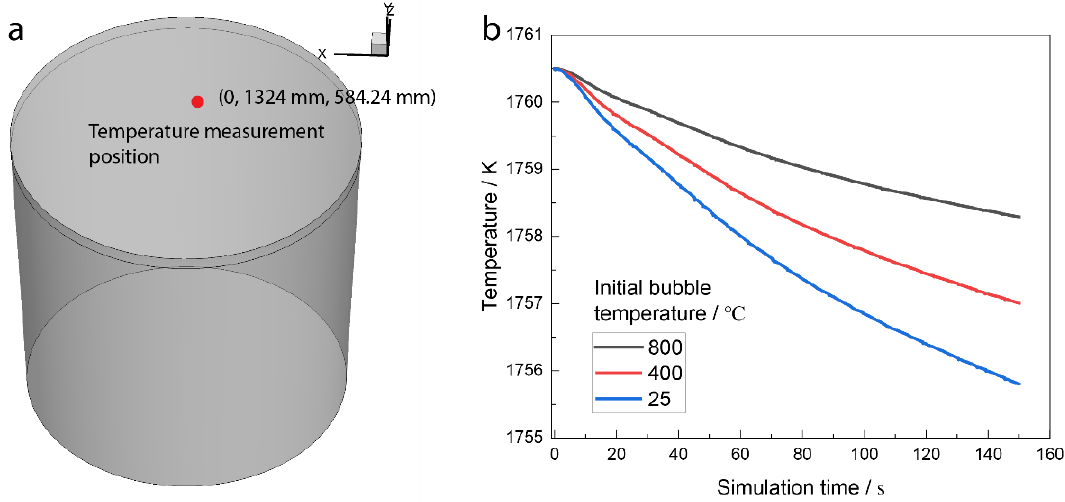
Figure 9. ( a ) Temperature measurements position in the industrial practice; ( b ) temperature varies with solution time at the temperature measurements position.